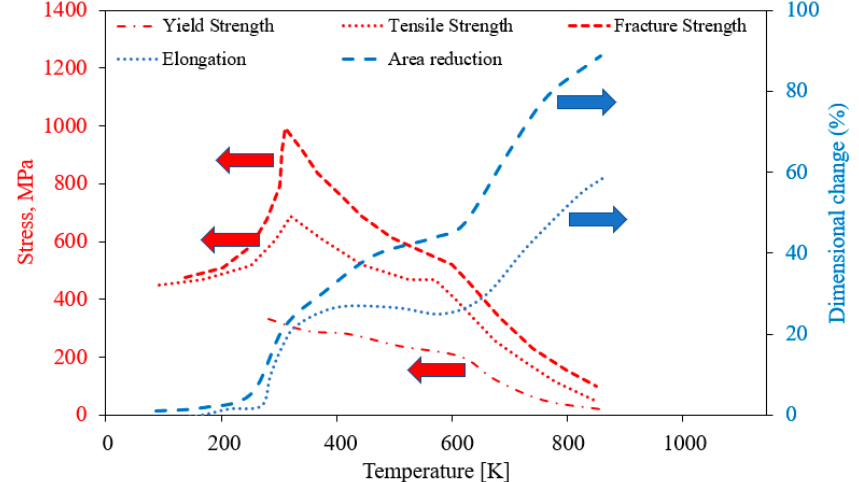
Figure 4. Mechanical properties of α -U as a function of temperature (Reprinted/adapted with permission from Ref. [24], 2022, Springer Nature). Red arrow represents Stress (MPa), and blue Dimensional change (%).